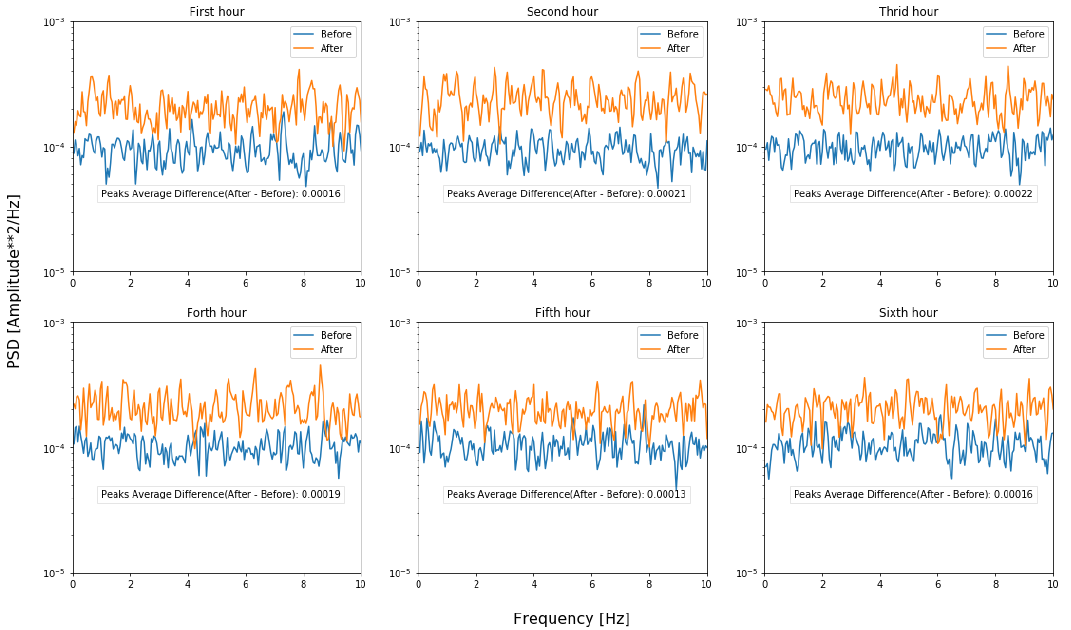
Figure 14. PSD Frequency domain plot for data collected from inside sensor before and after inserting Red Palm Weevils through